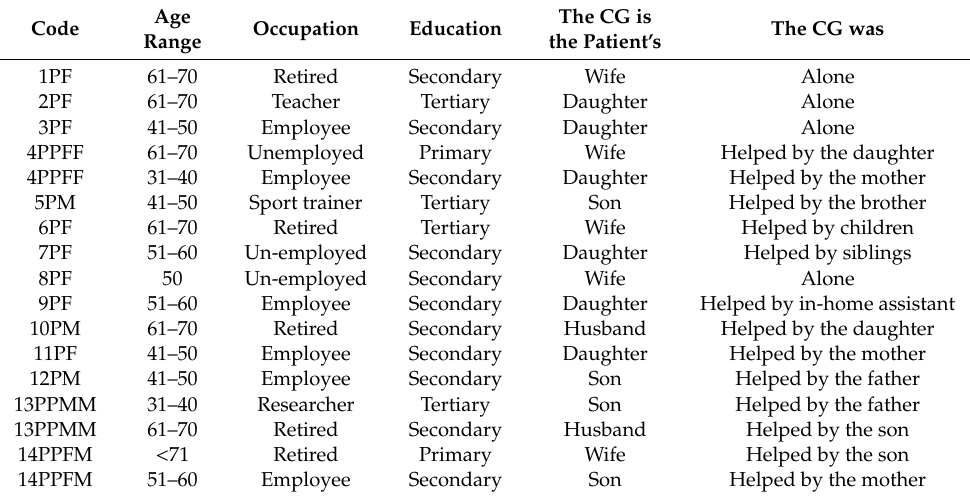
Table 3. Participants’ characteristics.